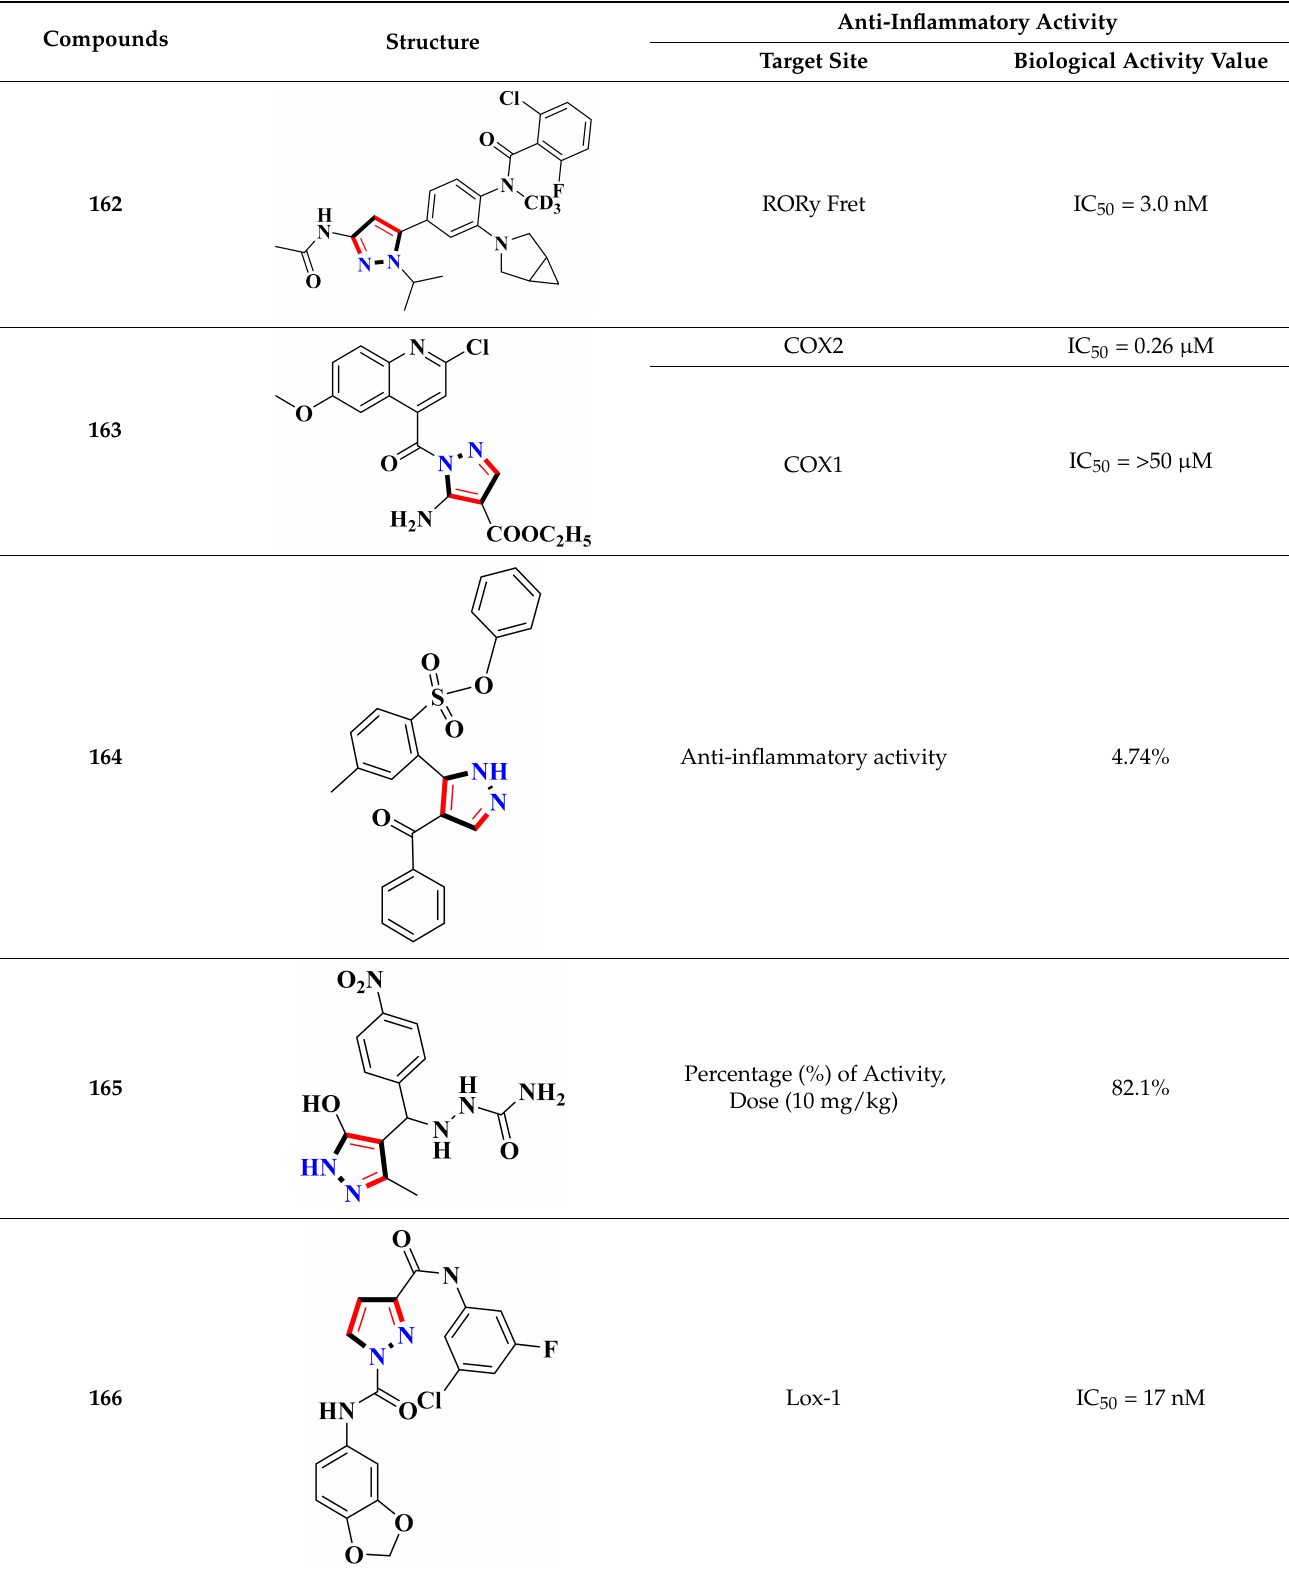
Table 12. Representative compound structures 162 to 175 and their anti-inflammatory